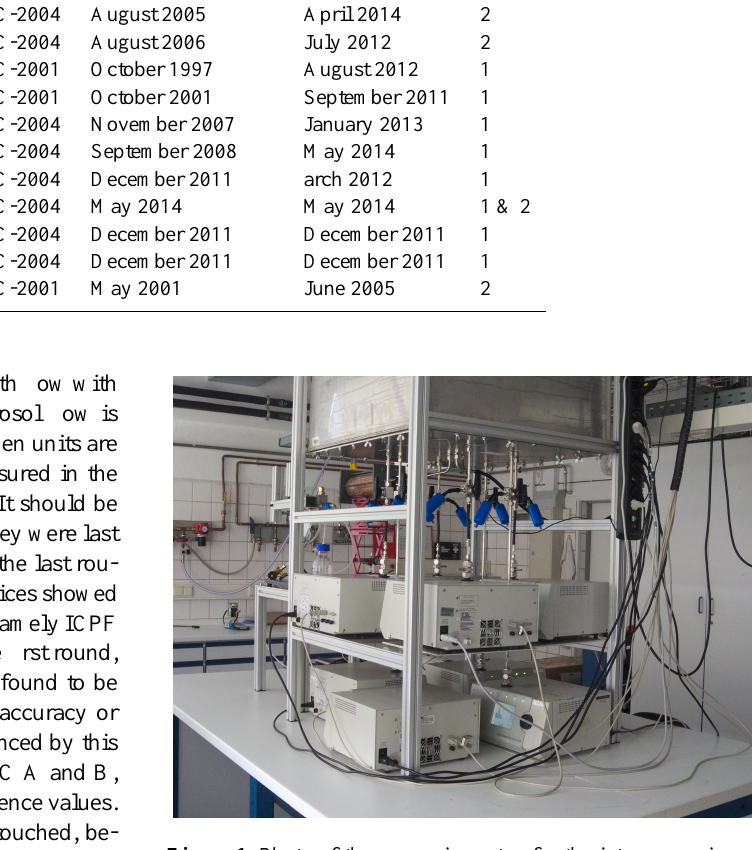
Figure 1. Photo of the measuring setup for the intercomparison of eight units APS